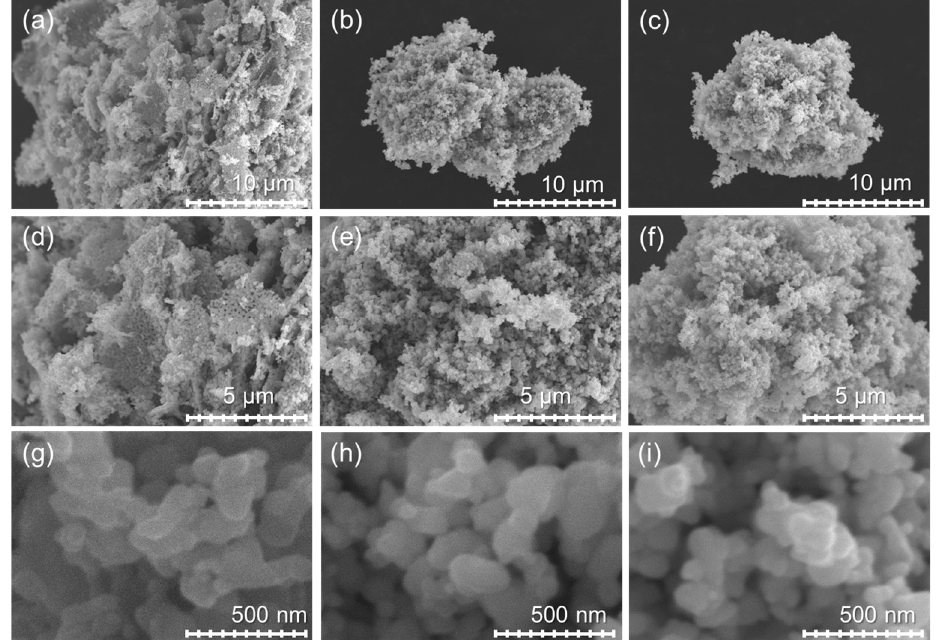
Figure 4. SEM micrographs of ZnO with the different ratios of ZA/ZN captured at 5000×, 10,000×, and 100,000× magnification of ( a , d , g ) ZnO ‐ 80/1, ( b , e , h ) ZnO ‐ 40/1, and ( c , f , i ) ZnO ‐ 20/1,